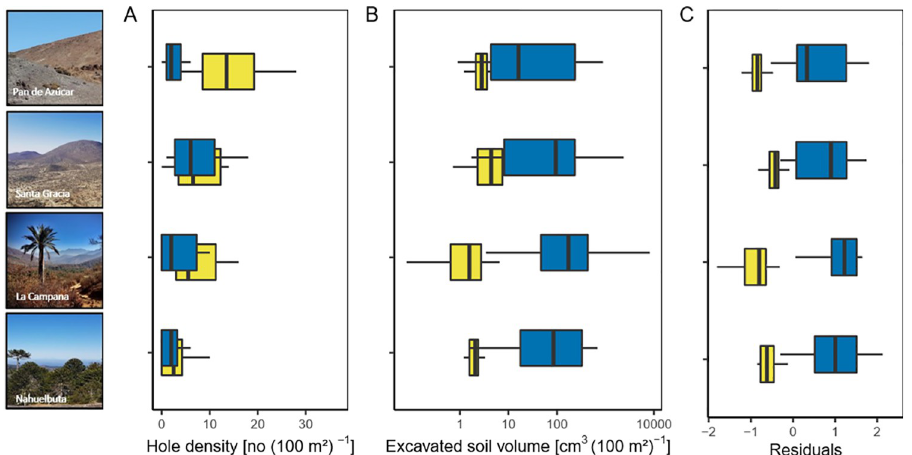
Fig 2. Bioturbation patterns of invertebrates (yellow) and vertebrates (blue) in each site (Pan de Azu´car, Santa Gracia, La Campana, Nahuelbuta). (A) Median hole density based on the raw data, (B) median excavated soil volume of holes, (C) the residuals of the excavated soil volume (log 10 -transformed) after correcting for hole density (log 10 - transformed) using separate regressions for the two animal groups. Note that the x-axis in (B) and (C) was log 10 -scaled. Data from the field campaign from September to November were used.